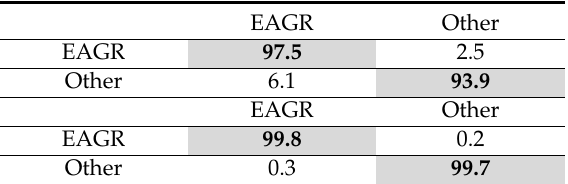
Table 7. Classification results of EAGR binary RF models that di ff ered by the addition of azimuth and range as spatially constraining variables. Values are percent of the total out-of-bag samples assigned to that class. Percent true positive classifications are highlighted and bold. “Other” is a class of resolution cells equally represented by all non-focal